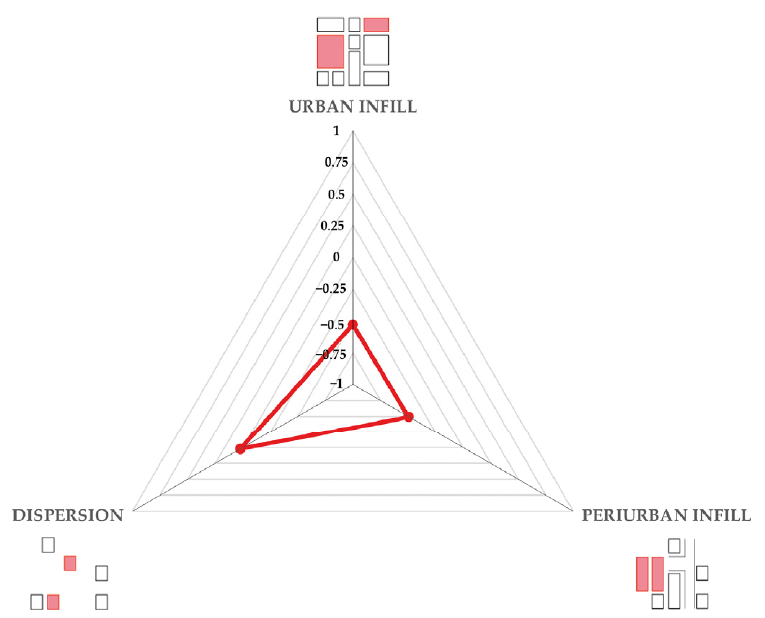
Figure 11. Value of the three indicators NDCL u , NDCL s , and NDCL r for the Italian urban municipal- ities. Overall, a tendency toward dispersion emerges, caused by a concentration of new buildings in rural areas.